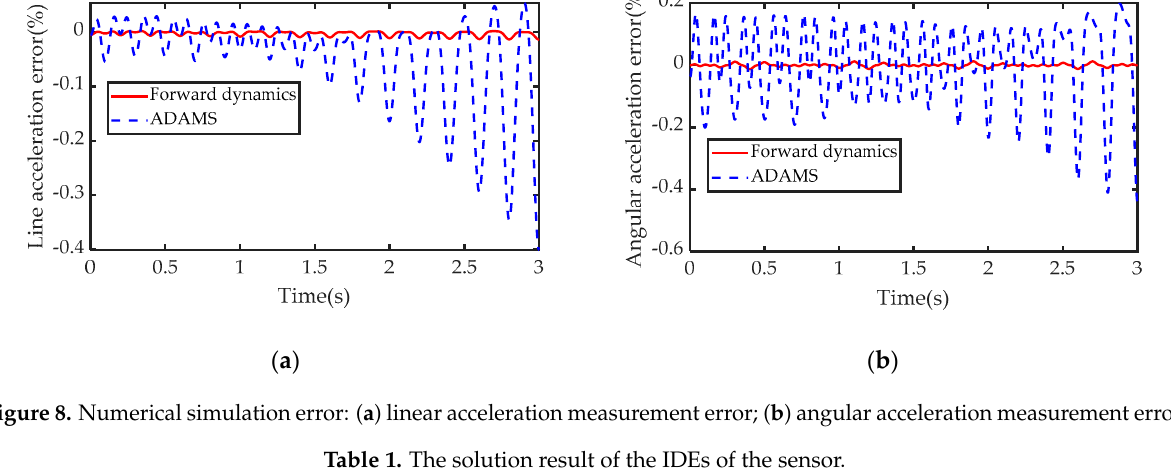
Figure 7. ( a ) Calculated and theoretical values of linear acceleration; ( b ) Calculated and theoretical values of angular acceleration.